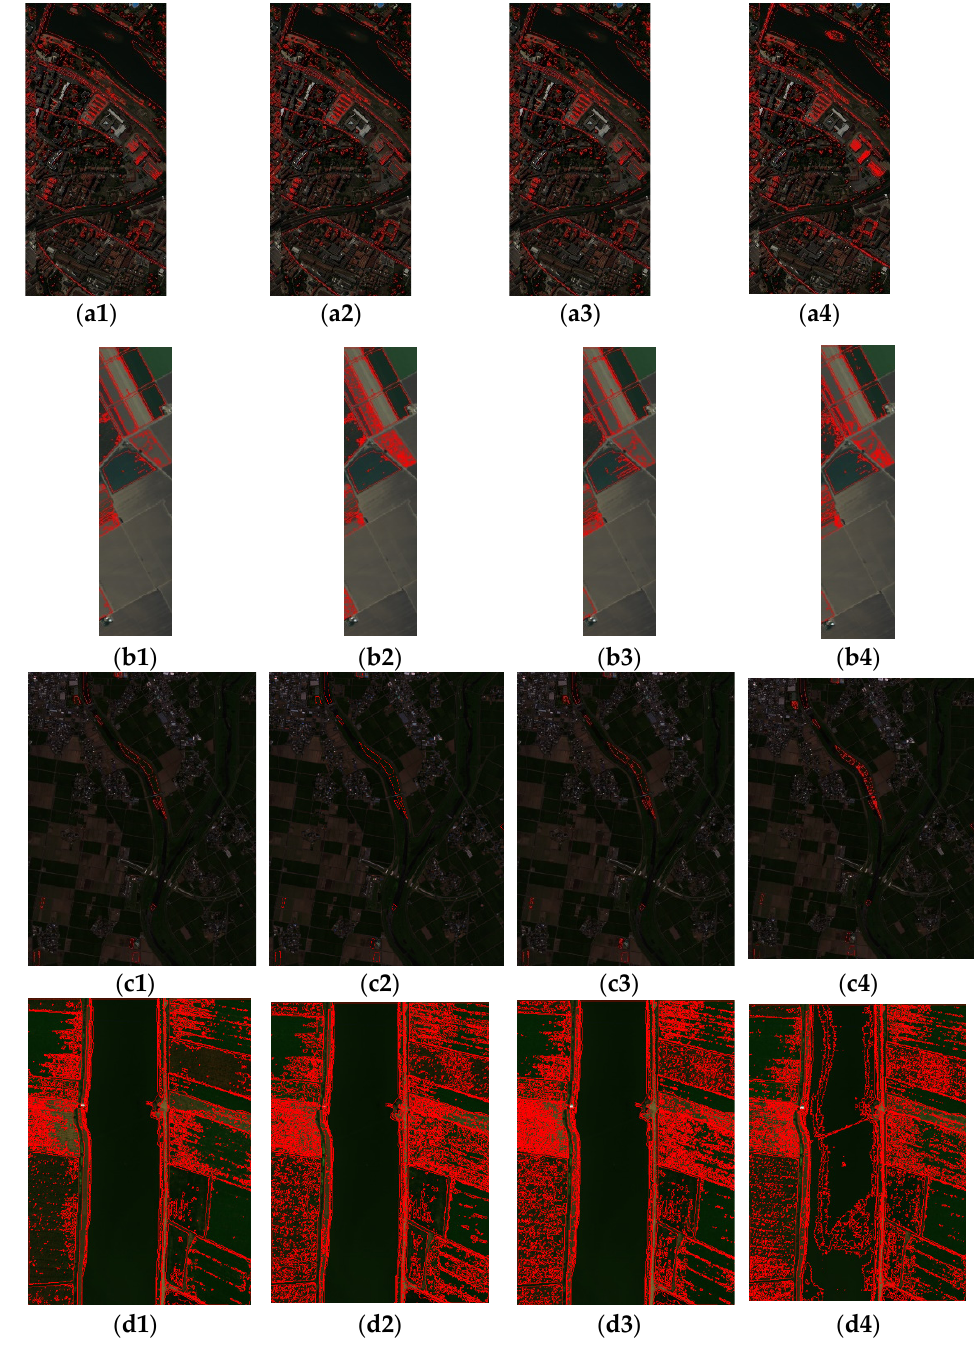
Figure 6. Comparison of outlines superposition results of four images. ( a1 – d1 ) The proposed algo- rithm. ( a2 – d2 ) TRP-MIV algorithm. ( a3 – d3 ) PRP-MGSR algorithm. ( a4 – d4 ) CAFCM algorithm. (The red lines are the outline of the classification results.)